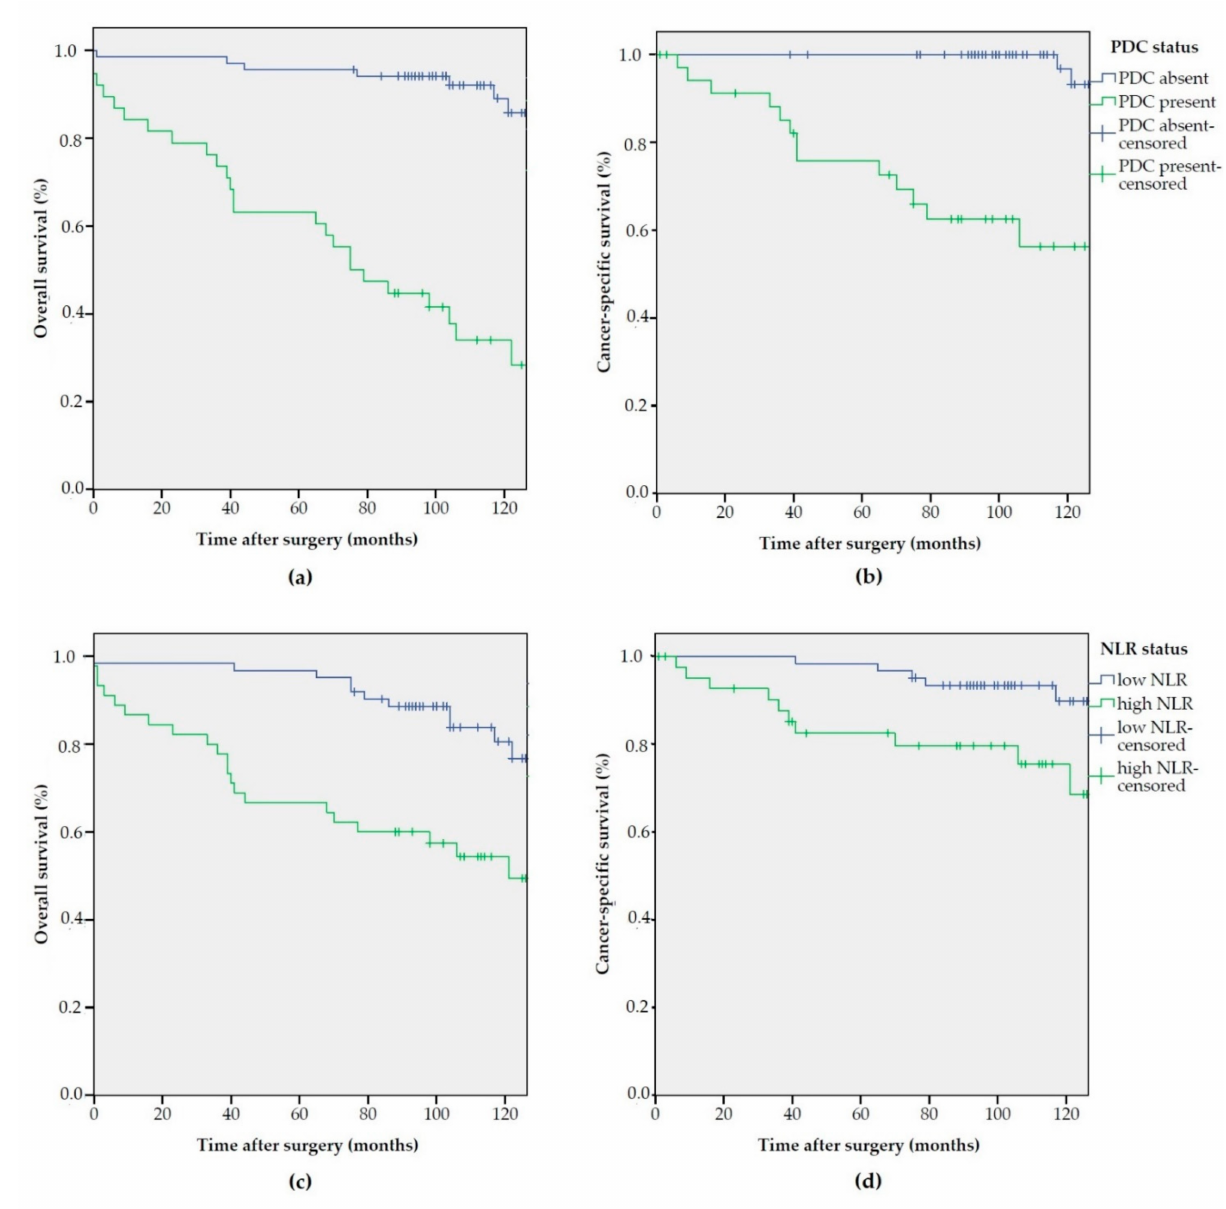
Figure 2. Kaplan–Meier estimates of overall survival (OS) and cancer-specific survival (CSS) according to PDC and NLR status: ( a ) OS according to PDC status ( p < 0.001); ( b ) CSS according to PDC status ( p < 0.001); ( c ) OS according to NLR status ( p < 0.001); and ( d ) CSS according to NLR status ( p =